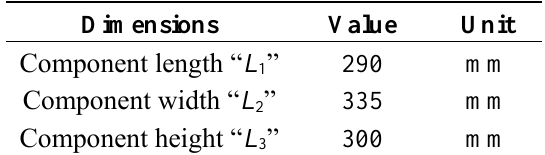
Table 13. Main dimensions of R245fa component.